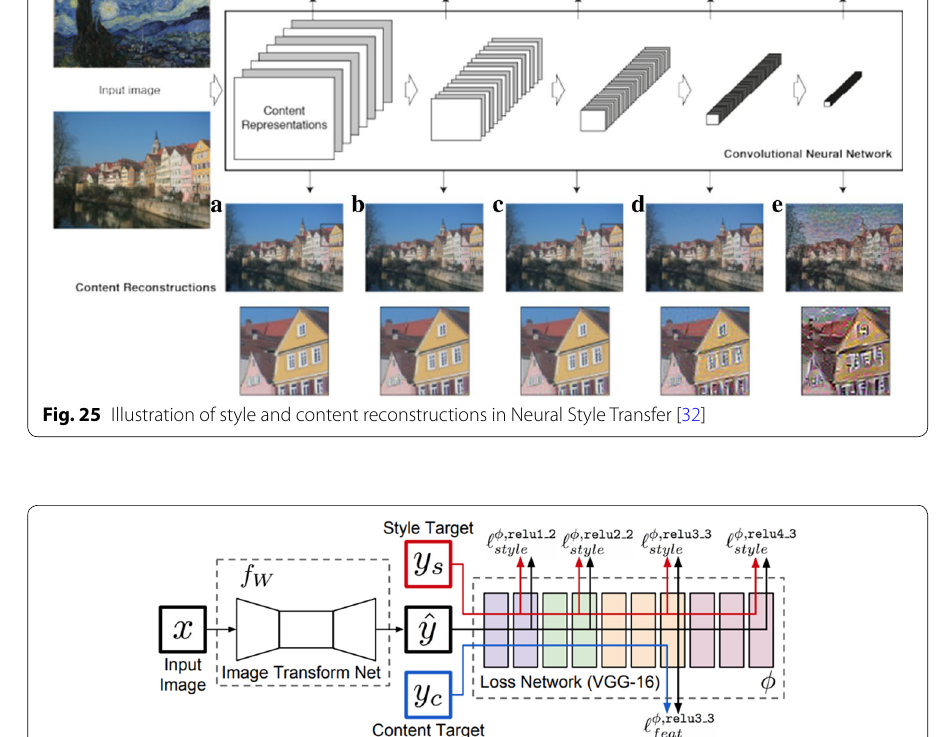
Fig. 26 Illustration of the Fast neural style algorithm by Johnson et al.